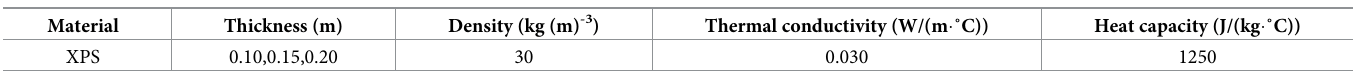
Table 9. Parameters of installation layer.